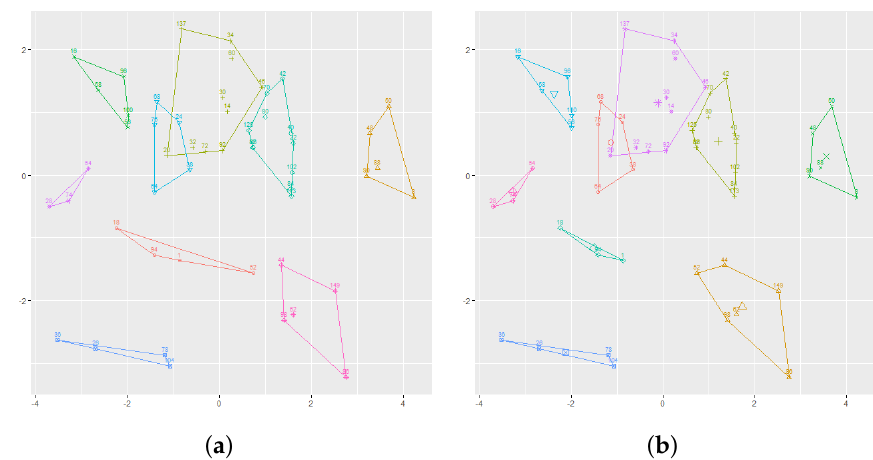
Figure 2. Crop partitions for Bjerringbro. The first and second components appear along the horizontal and vertical axes, respectively. ( a ) K-medoids for Bjerringbro. ( b ) Fuzzy K-means for